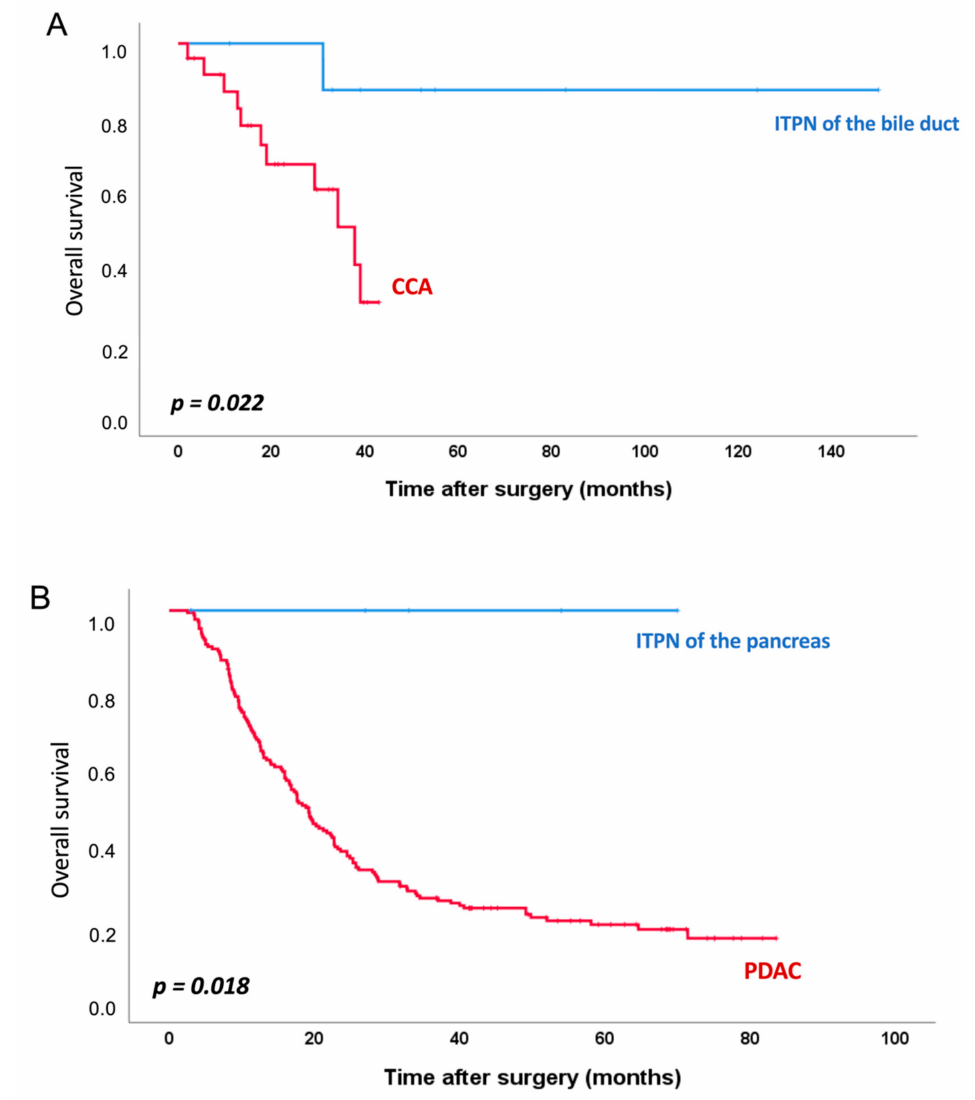
Figure 2. Survival analyses. Kaplan–Meier survival curves comparing overall survival of ITPN of the bile duct ( n = 9) with cholangiocarcinoma (CCA) ( n = 25) ( A ), and ITPN of the pancreas ( n = 5) with pancreatic ductal adenocarcinoma (PDAC) ( n = 173) ( B